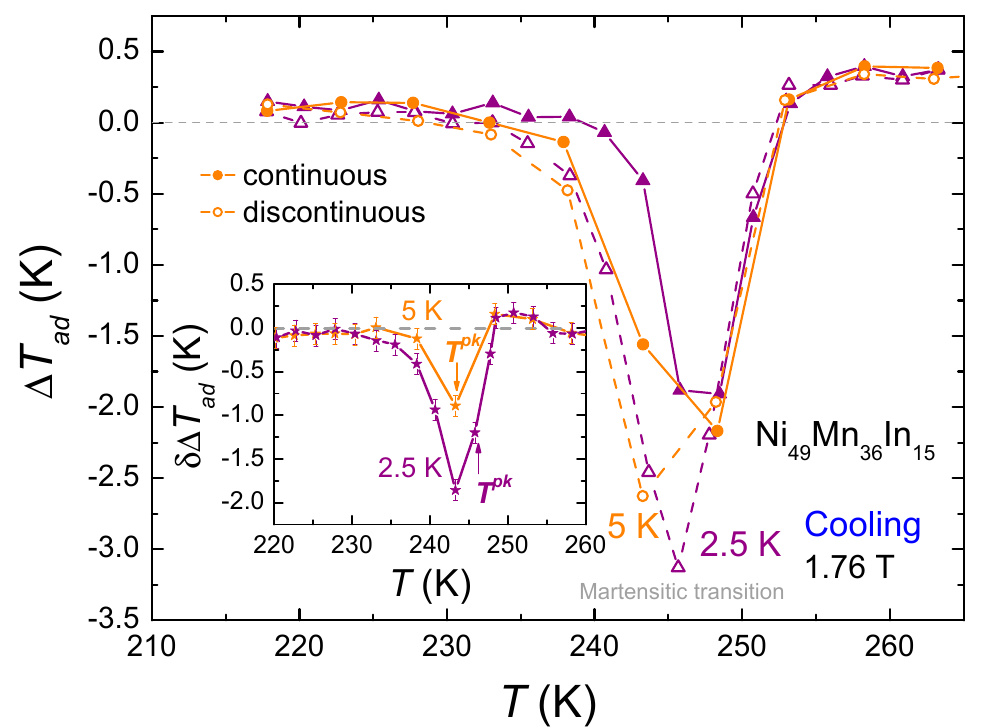
Figure 3. Temperature dependence of the adiabatic temperature change ( Δ T ad ) of Ni 49 Mn 36 In 15 sample using discontinuous and continuous heating protocols (open and solid symbols, respectively) with a temperature step of 5 K. Inset: differences between both Δ T ad curves ( δΔ T ad ).